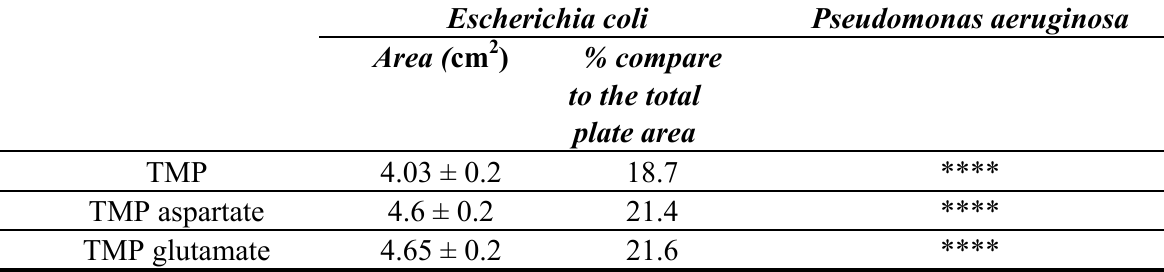
Table 3. Zone of inhibition studies of TMP and its prepared salts against Escherichia coli and Pseudomonas